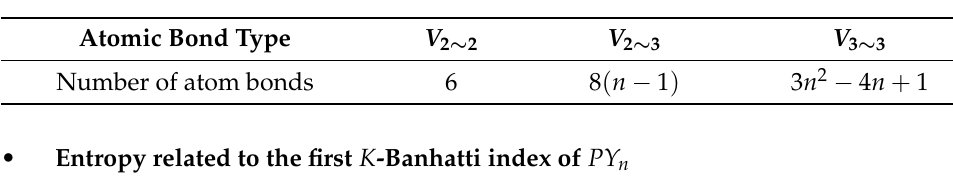
Table 1. Atomic bond partition of PY n